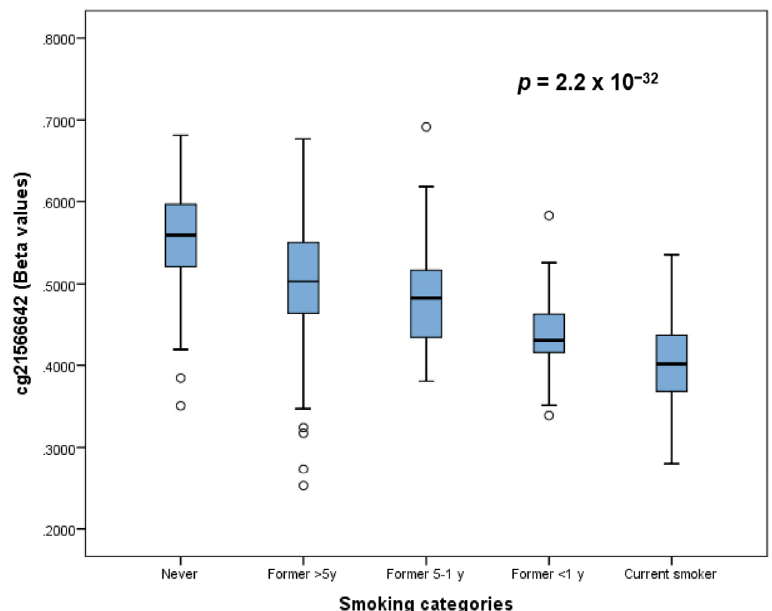
Figure 3. Box plots of distributions showing methylation (beta ‐ values) of the cg21566642 site (chro ‐ mosome 2) by smoking status (5 levels). The box plots show the five ‐ number summary of a set of data: the minimum score, first (lower) quartile, median, third (upper) quartile, and maximum